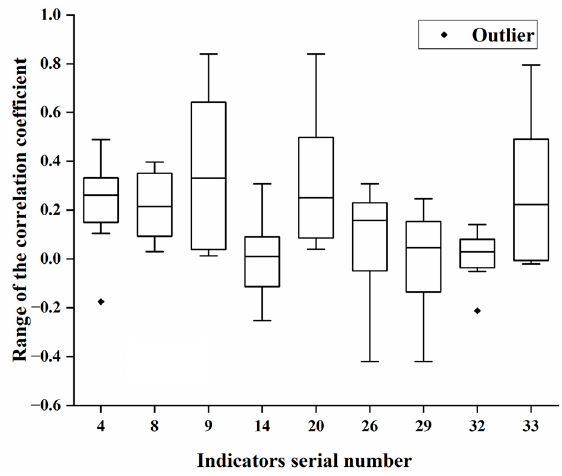
Figure 7. Correlation coefficient between 9 preferred indicators.